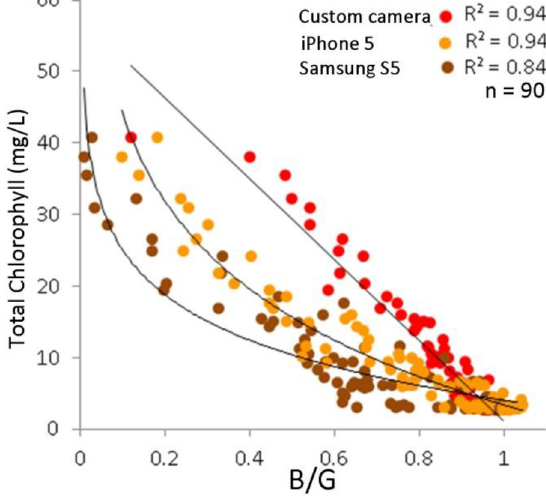
Fig. 5. Correlation between total chlorophyll in chlorophyllin solution and turbidity levels.